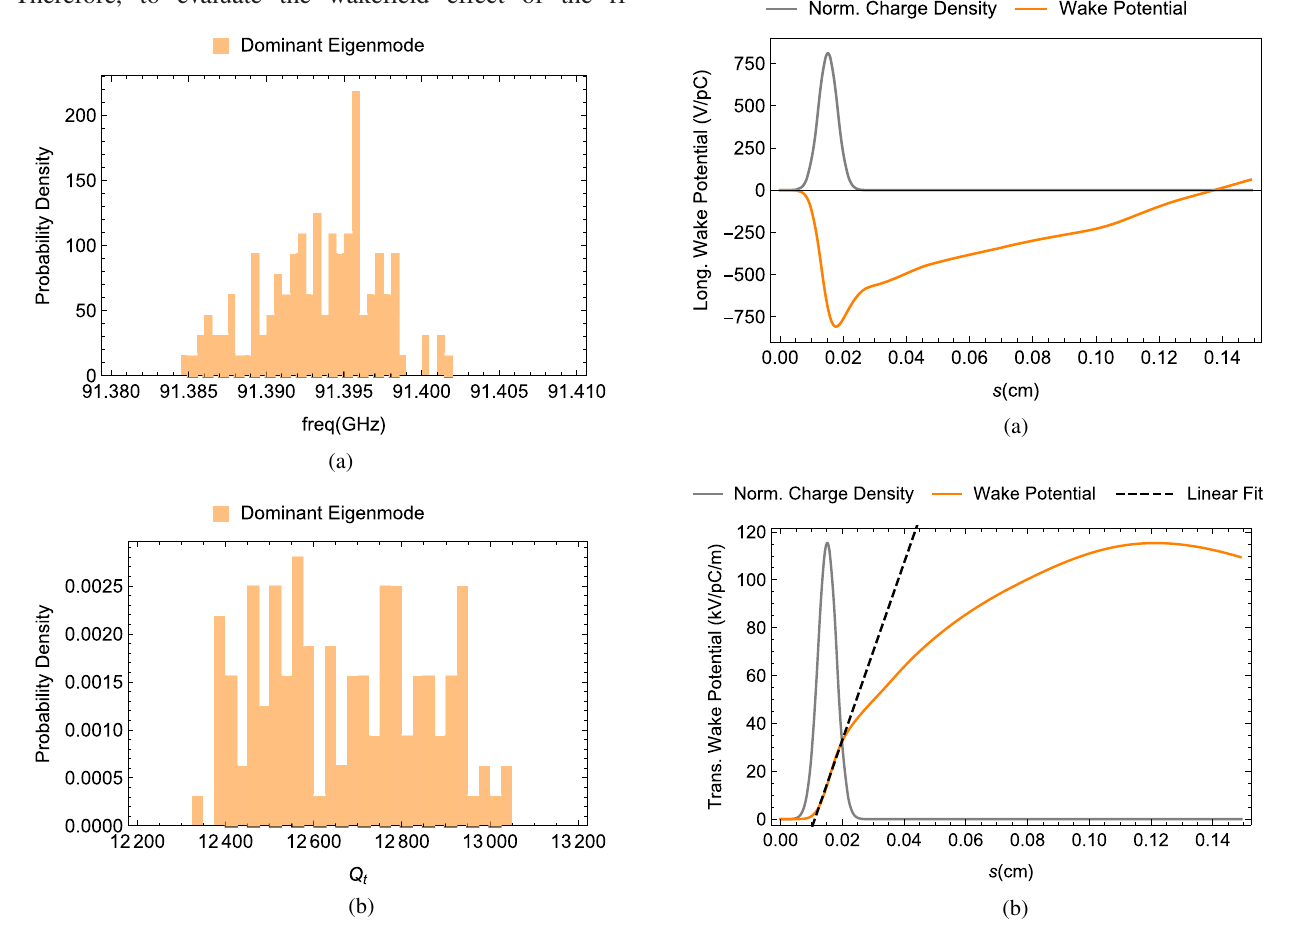
FIG. 12. Cavity eigenfrequency and total quality factor tolerances, obtained by varying 5 geometrical parameters uniformly (cid:2) 5 μ m. (a) Eigenfrequency tolerances and (b) total quality factor tolerances.